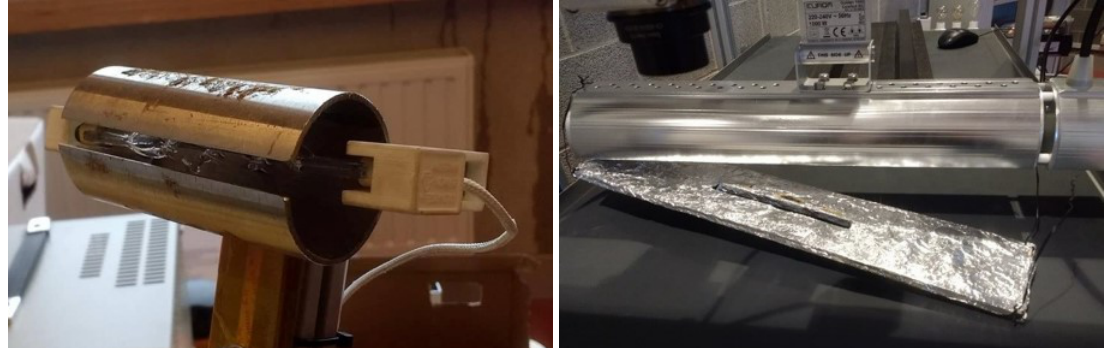
Figure 1. Two experimental set-ups are displayed as they are used in our lab: ( Left ) cylindrical reflector constructed to concentrate the radiation in a narrow line. This heater is used in dynamic measurements as a hand-held heater. Starting from a hollow tube a slit was milled with the desired width in order to create the reflector shape. ( Right ) empirical test-setup for Dynamic Line Scan Thermography on a conveyor belt. A wooden plate wrapped in aluminium foil was mounted underneath a patio heater. In the middle of the plate, a slit with desired width and length was cut in order to create the reflector shape. Both setups use a thin slot to minimise the heated region. Only the electromagnetic radiation passing through the slit will heat up the specimen to be inspected. Other rays will be blocked and thereby a large amount of energy is